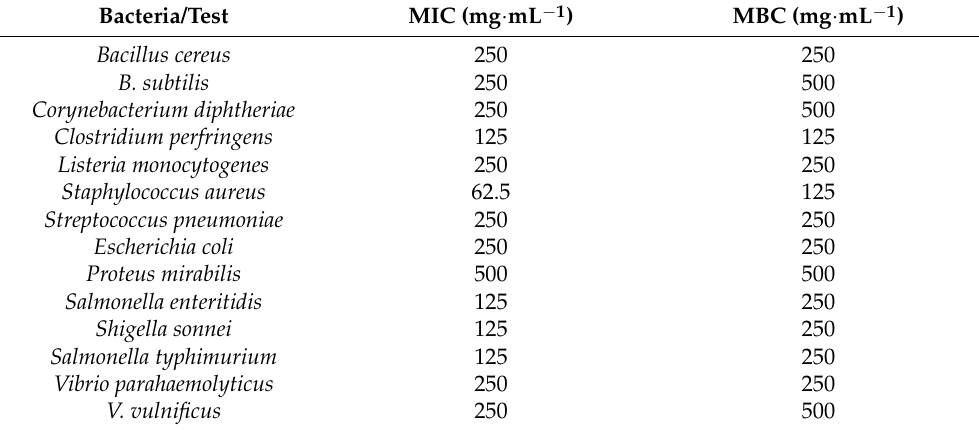
Table 5. Evaluation of Minimum Inhibitory Concentration and Minimum Bactericidal Concentration (MBC) of NE-FLO on different bacteria.